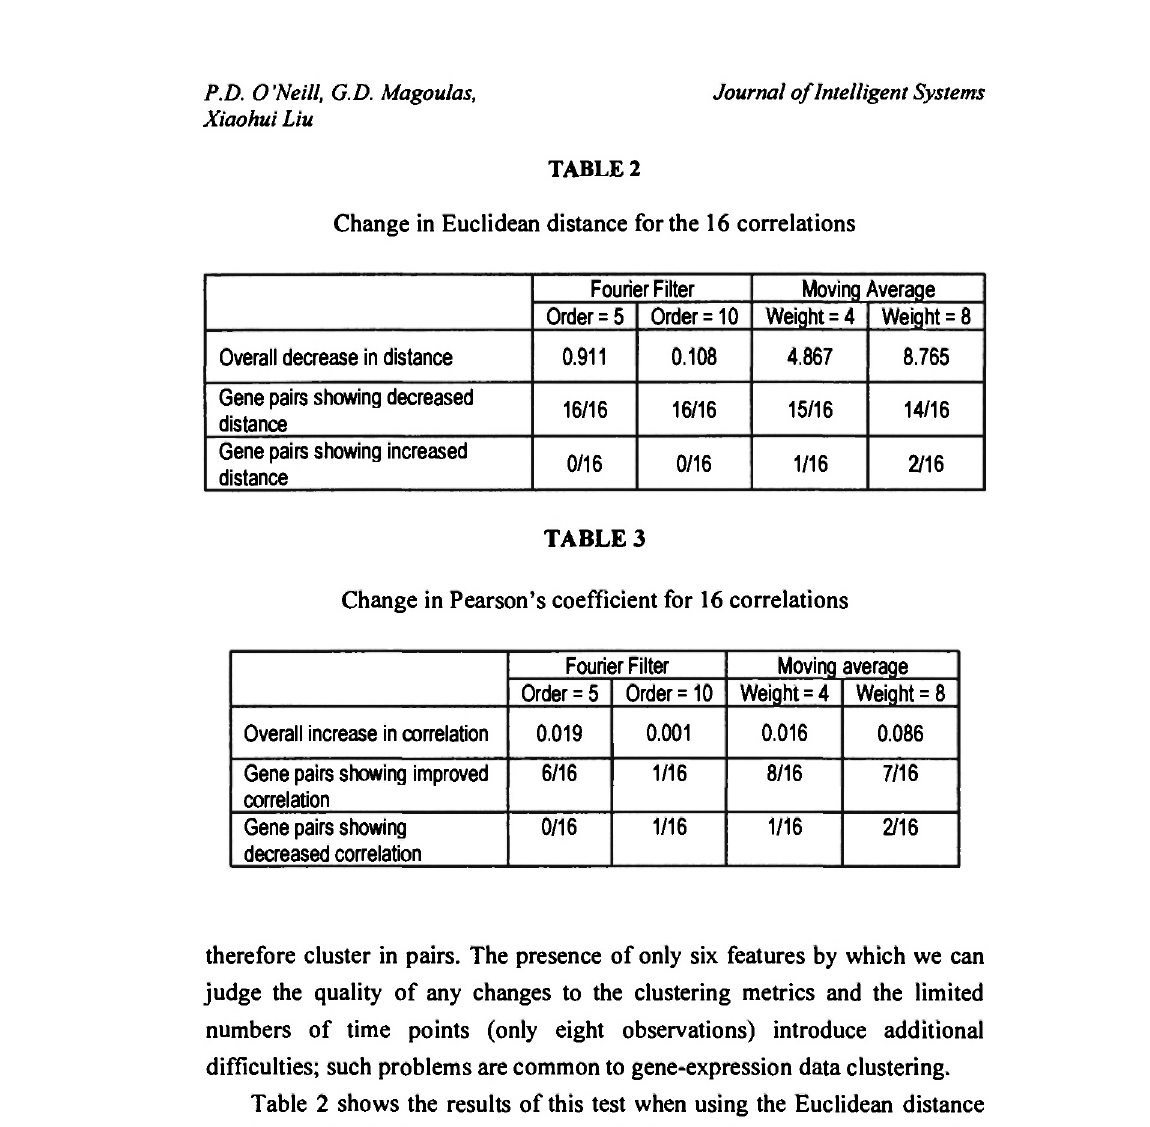
Change in Euclidean distance for the 16